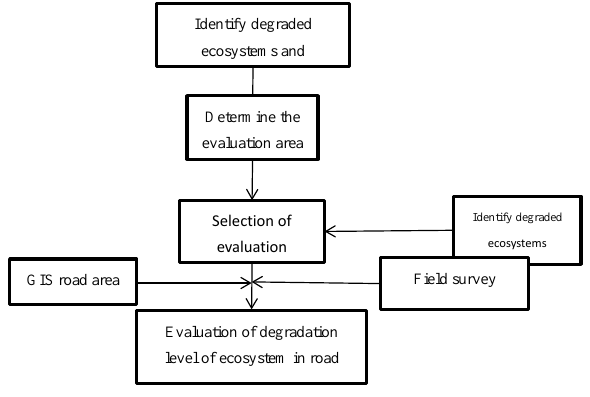
Figure 1: Steps of the overall study